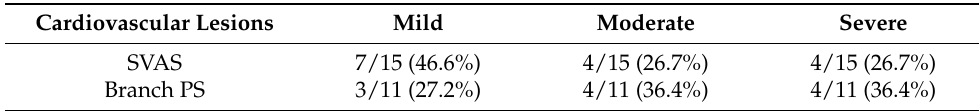
Table 2. Severity groups of SVAS and branch